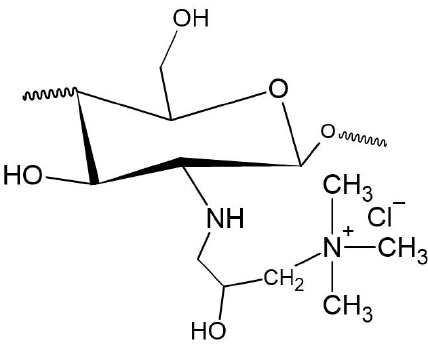
Figure 3. Molecular structure of N-(2-hydroxyl)propyl-3-trimethyl ammonium chitosan chloride